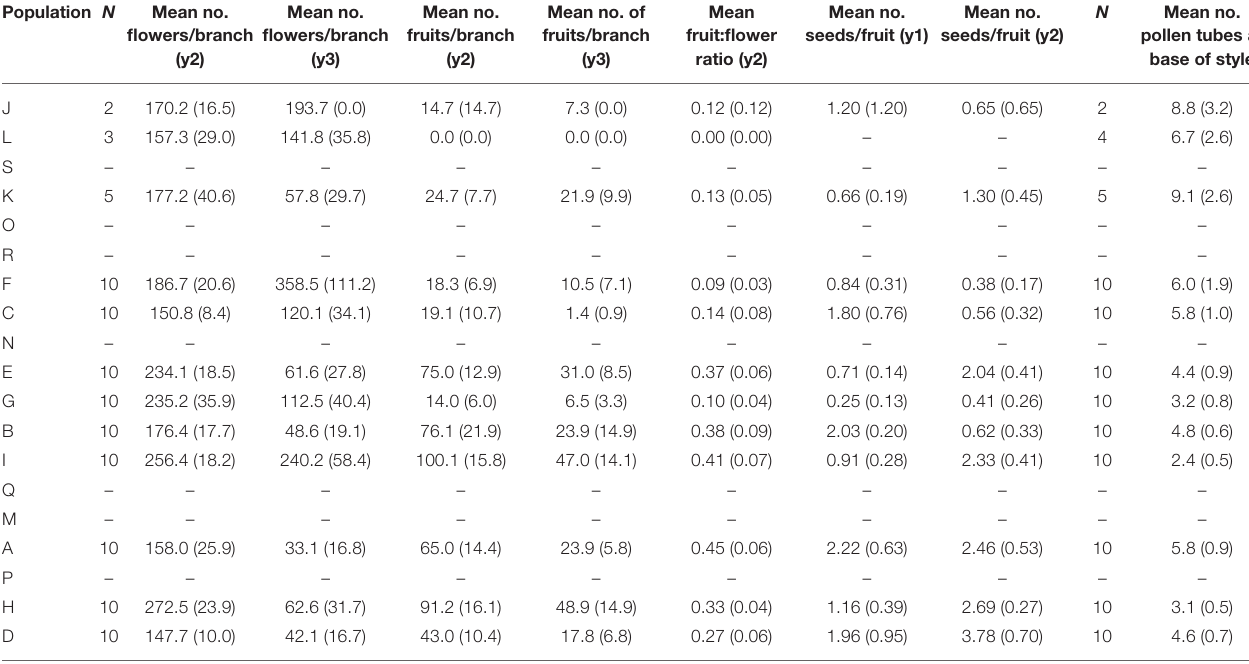
TABLE 6 | The mean number of flowers, fruits, seeds and pollen tubes for 12 populations of Eucalyptus wandoo . Population N